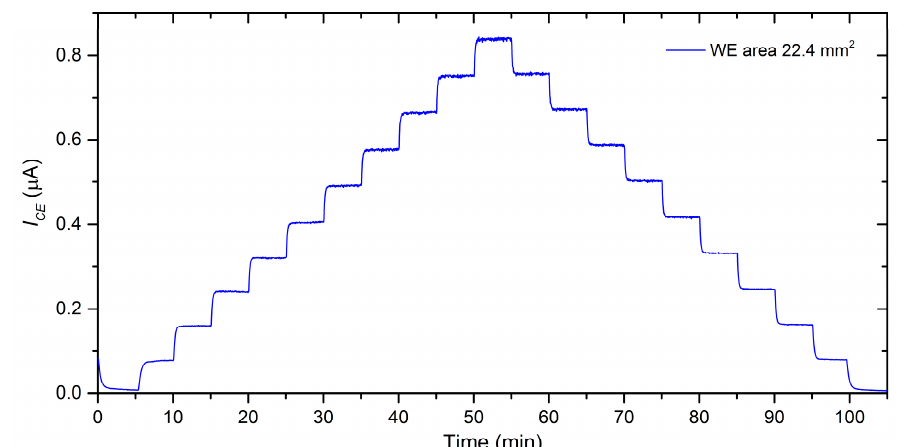
Figure 8. Sensor response to stepwise increase in NO 2 concentrations within the range of 0 − 1 ppm (1 step equaled 100 ppb), WE surface area of 22.4 mm 2 conditions: 298 K, 40 %RH, analyte flow rate 1 L / min.